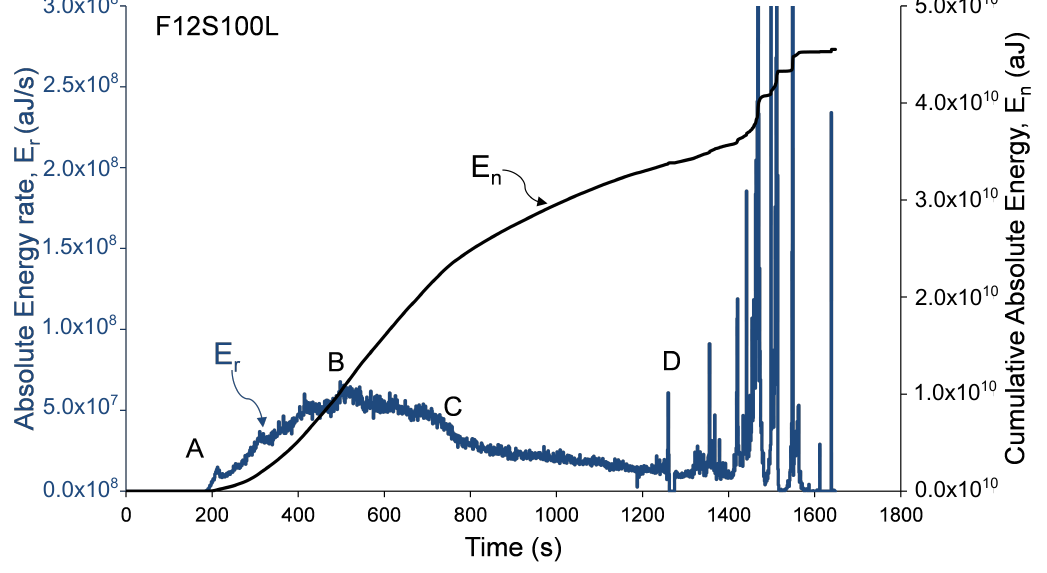
Figure 8. Absolute and cumulative absolute energy versus time—specimen